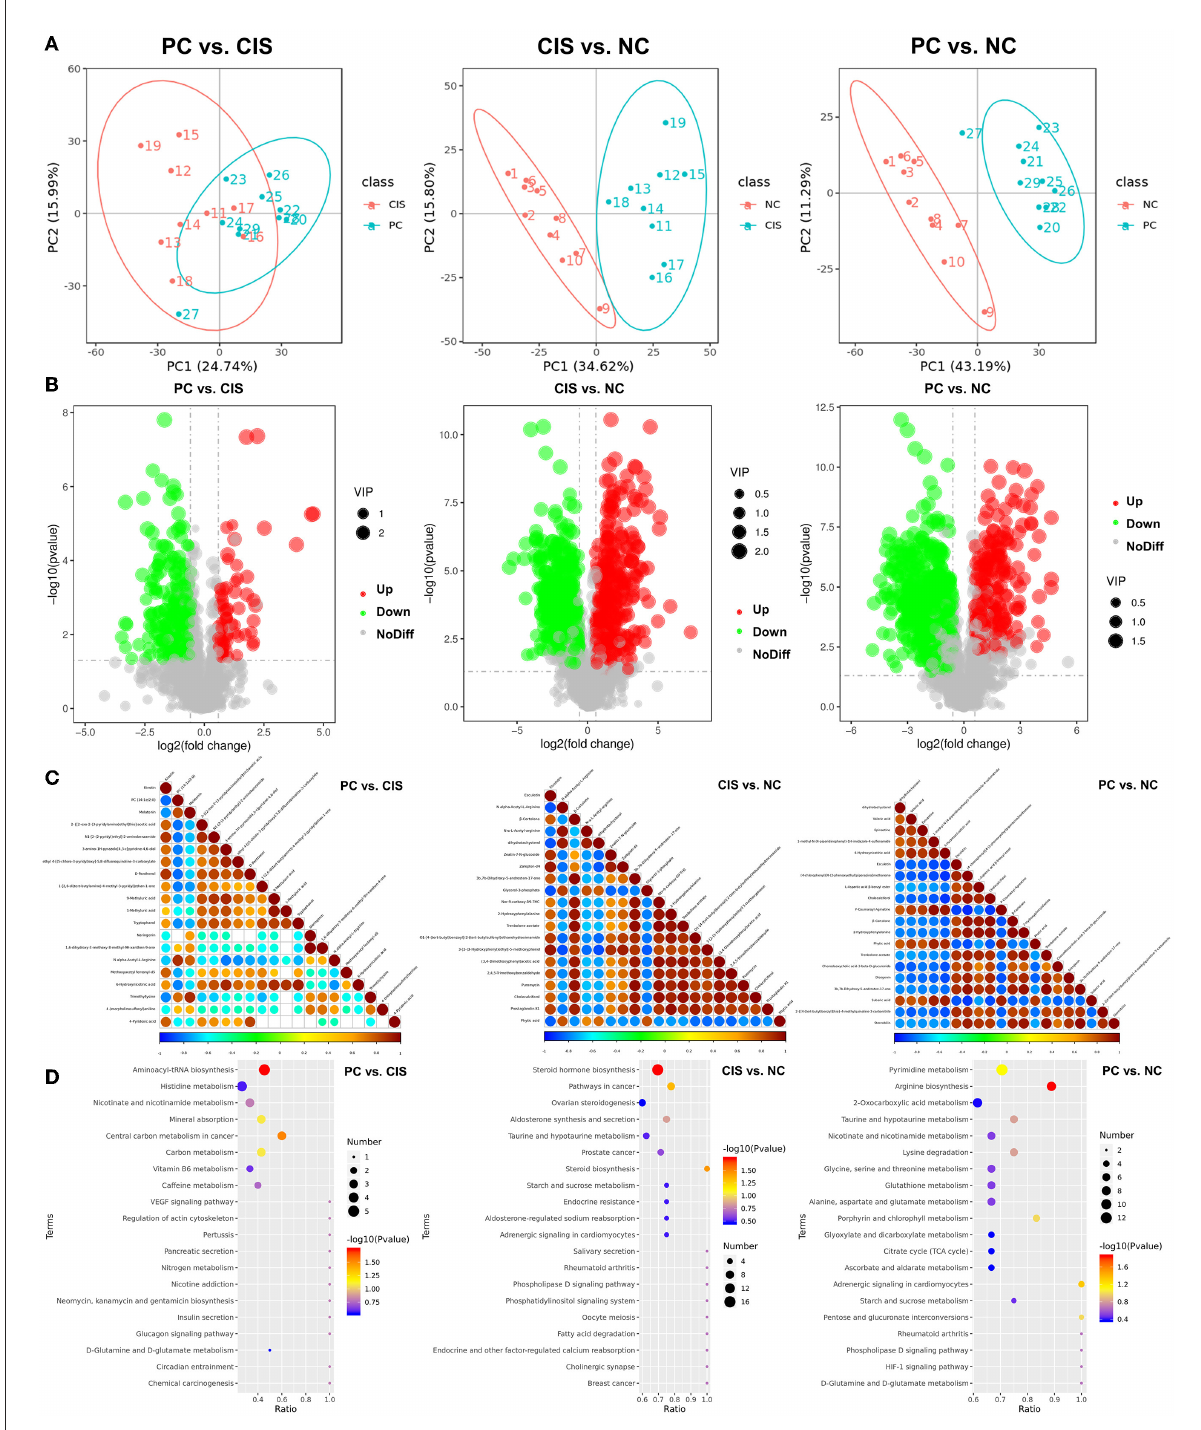
FIGURE5 Metabolomics analysis in feces. (A) Principal components analysis (PCA) of all metabolic pathways in the three groups; (B) volcano map of differential metabolites in the three groups (Up: significantly increase p < 0.05; Down: significantly decrease p < 0.05; NoDiff: no significant difference p > 0.05); (C) the top 20 differential metabolite correlation plots in the three groups; (D) KEGG analysis of differential metabolites in the three groups. n = 10 for the PC and CIS groups, n = 9 for the CIS group (one mouse in the CIS group died before collecting feces). Z-score value represents the normalized abundance. VIP value represents the correlation coefficient. NC, normal control; CIS, cisplatin; PC, cisplatin with